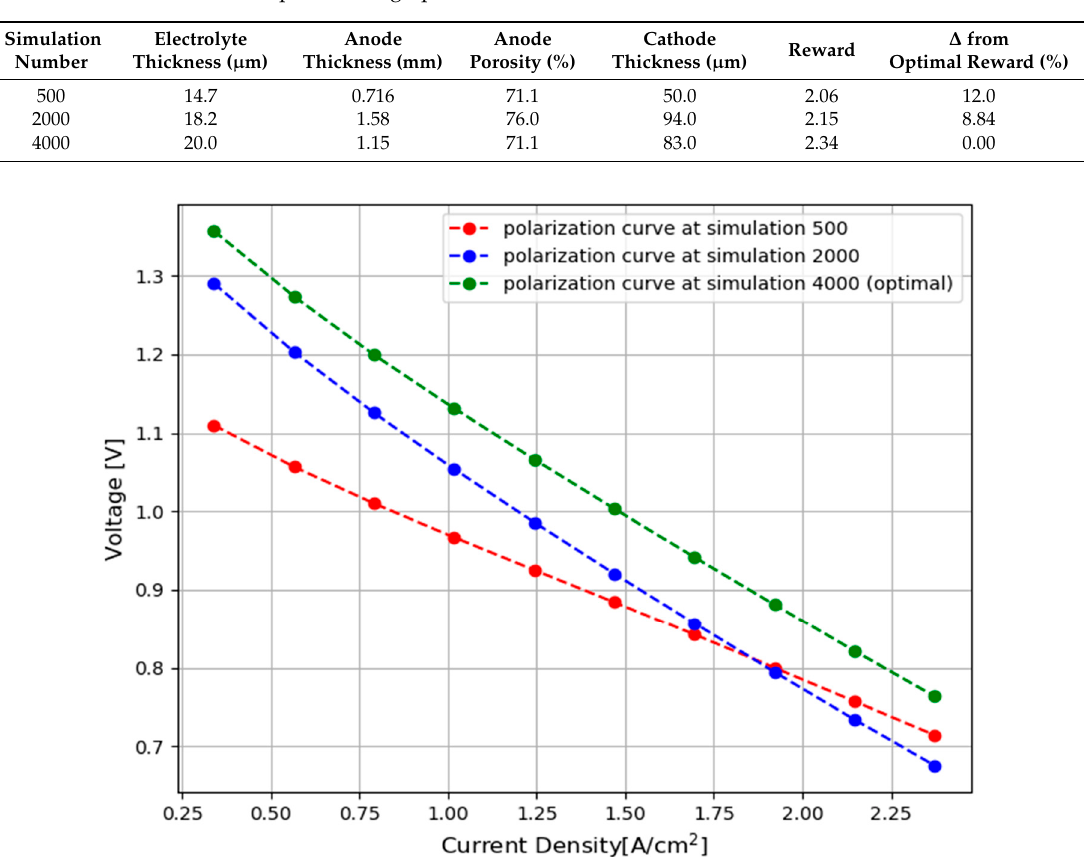
Figure 6. Polarization curves for the design parameters selected at simulation steps 500, 2000, and 4000.